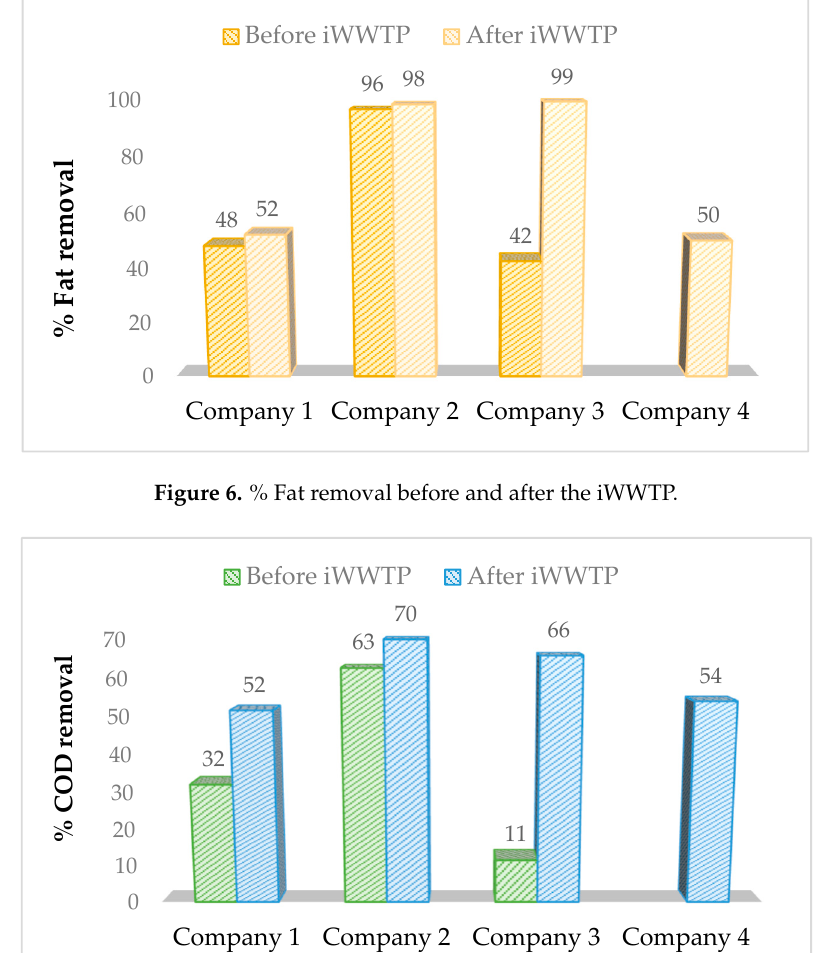
Figure 7. % of COD removal before and after the iWWTP .